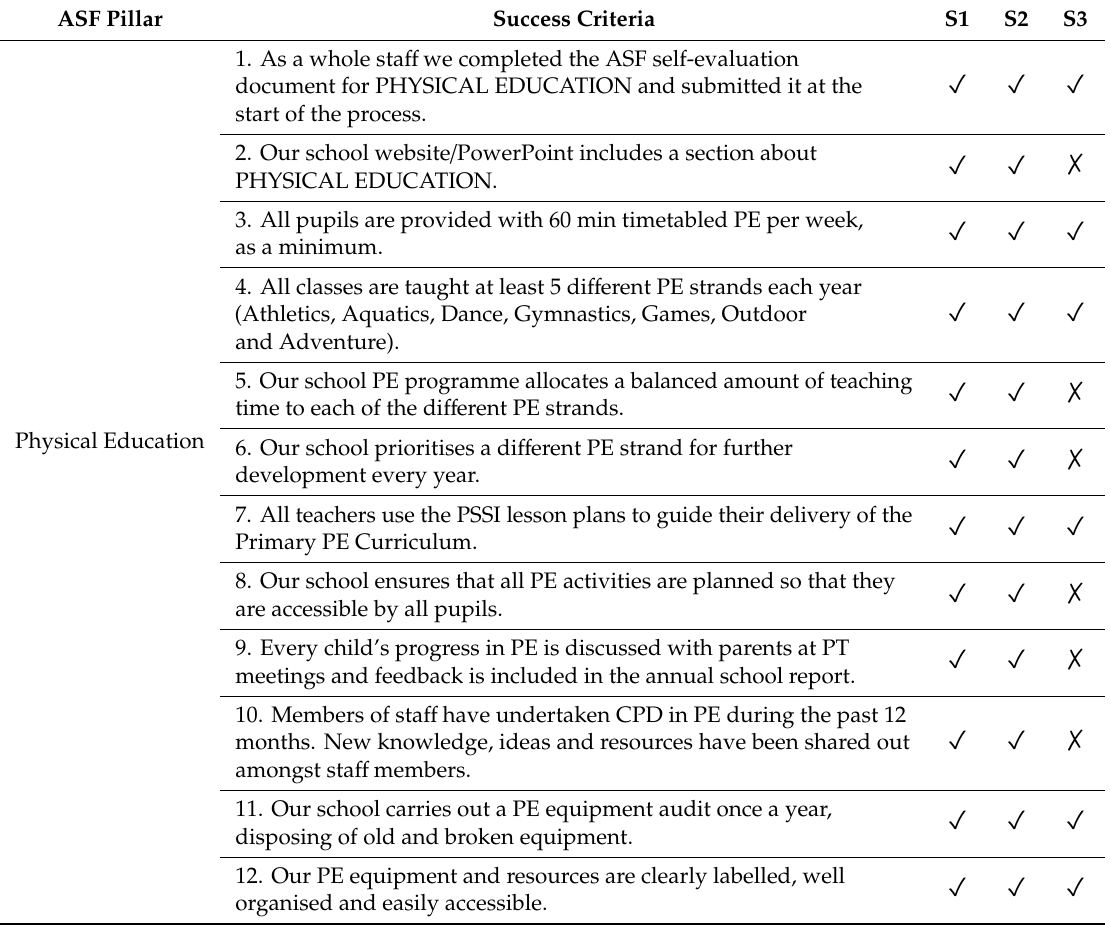
Table 2. ASF success criteria achieved by each case study school.